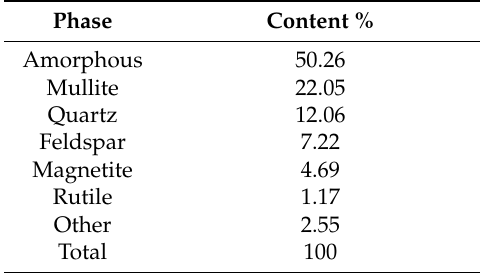
Table 3. Semi-quantitative determination of mineral phases in raw CFA.